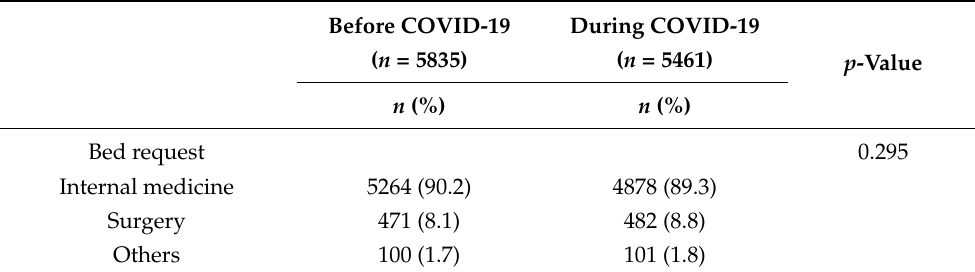
Table 2. A comparison of the characteristics of elderly boarded patients in the emergency department (ED) during the COVID-19 pandemic versus during the pre-pandemic period. Before COVID-19 During COVID-19 p -Value( n = 5835) ( n = 5461) n (%) n (%) Bed request 0.295 Internal medicine 5264 (90.2) 4878 (89.3) Surgery 471 (8.1) 482 (8.8) Others 100 (1.7) 101 (1.8)